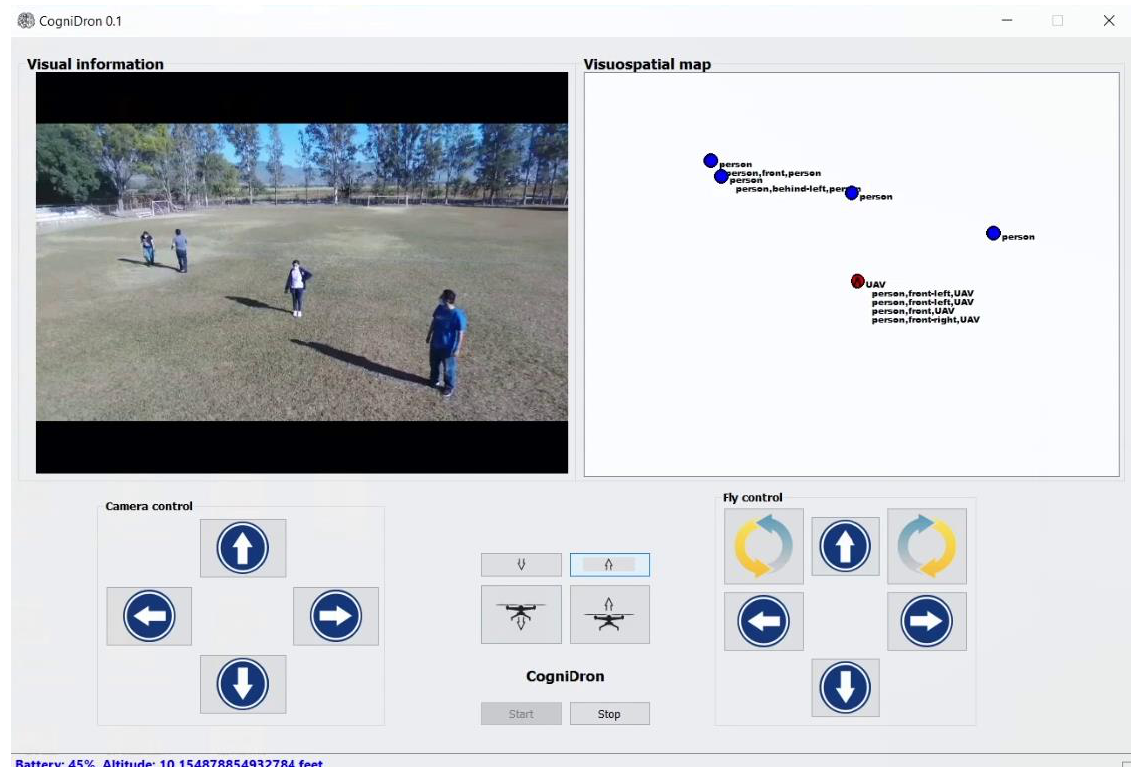
Figure 8. Additional fuzzy spatial relationship information between relevant stimuli when they are close to each other.